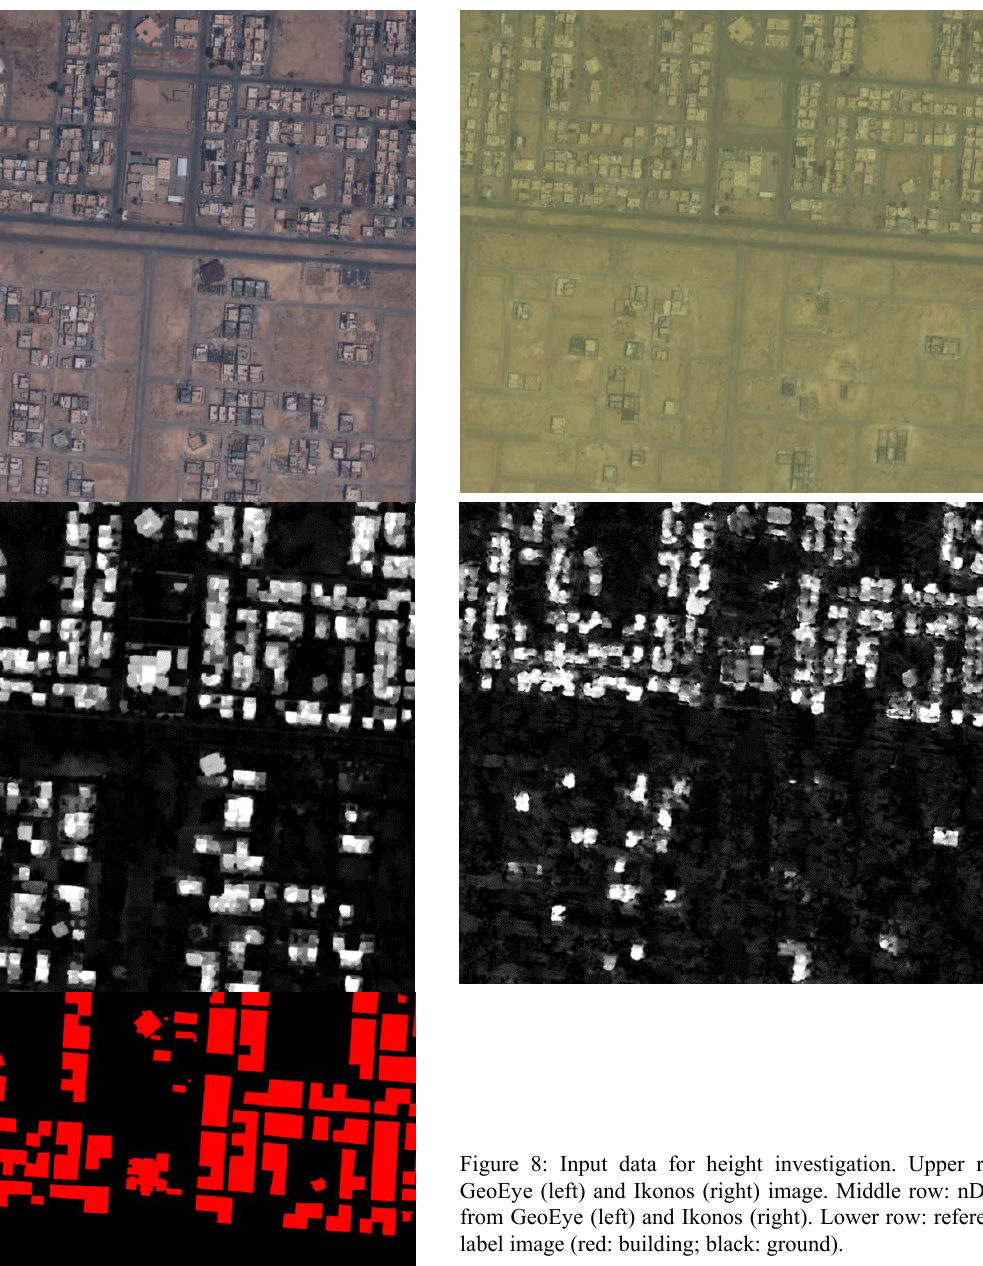
Figure 8: Input data for height investigation. Upper row: GeoEye (left) and Ikonos (right) image. Middle row: nDSM from GeoEye (left) and Ikonos (right). Lower row: reference label image (red: building; black: